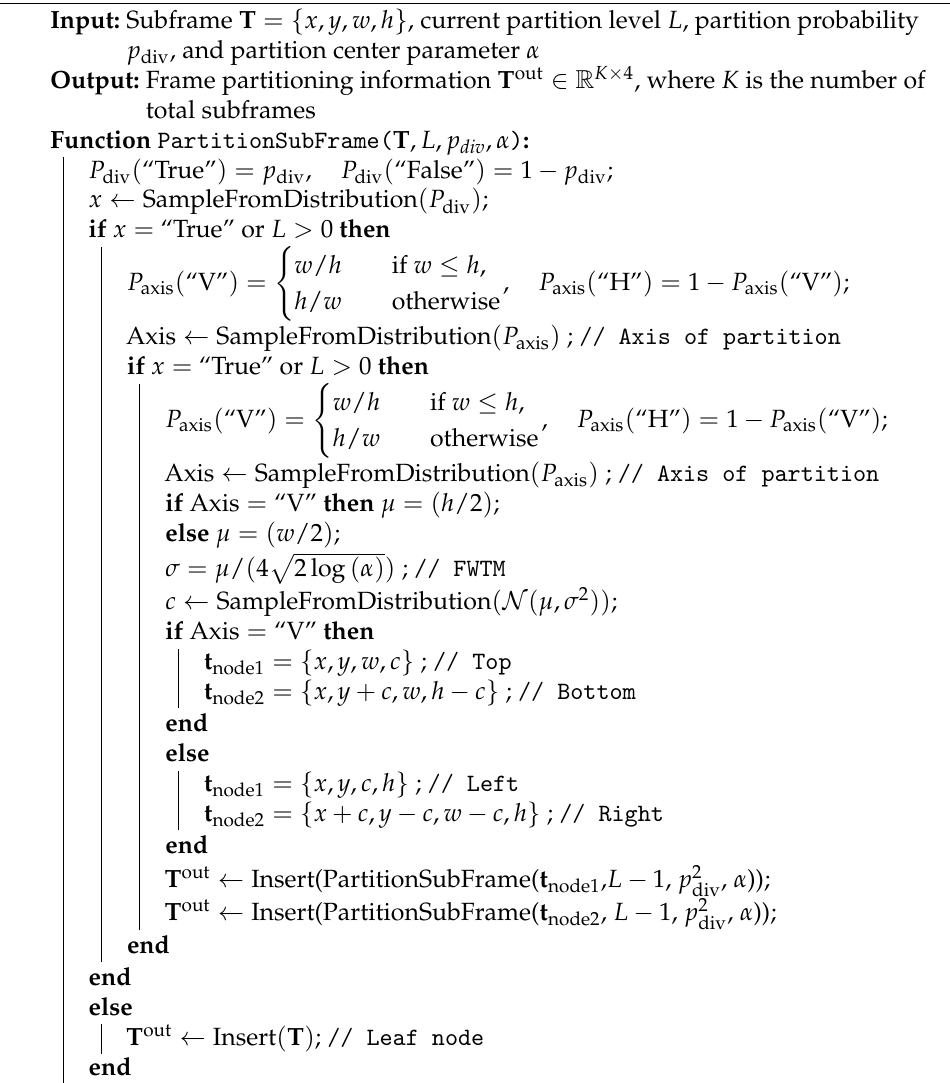
Algorithm 1: Generating the template by the partitioning